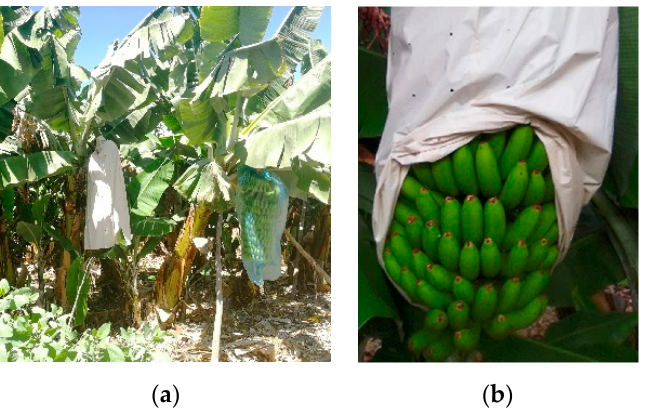
Figure 9. Validation in field of the 3rd biofilm generation, ( a ) control and developed bags after installation in field, ( b ) state of bananas during the maturation in the final developed bag.